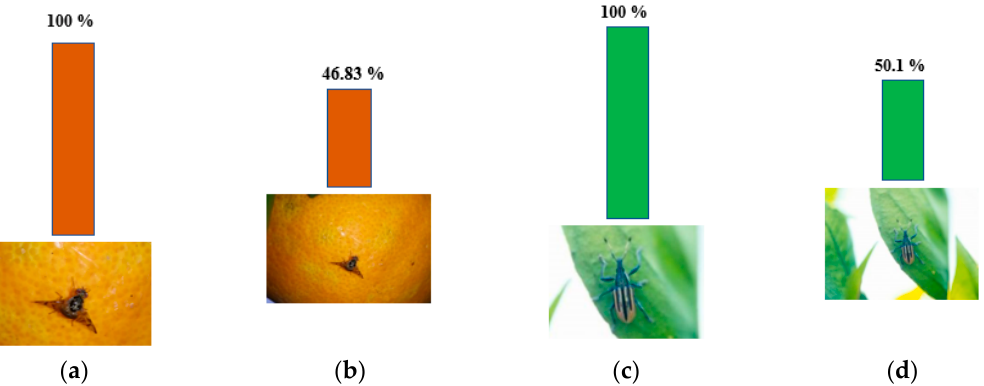
Figure 6. Prediction accuracy of Weakly DenseNet-19 for the different scales of target objects: ( a , b ) fruit fly; ( c , d ) root weevil.